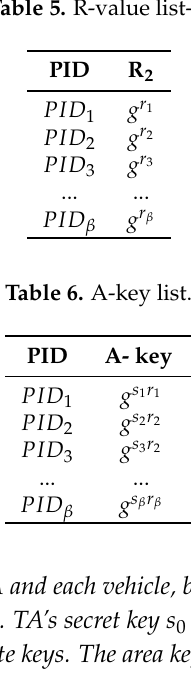
Table 5. R-value list-2.